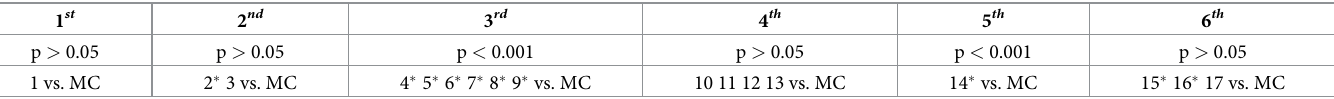
Table 3. Statistical analysis of individual step assessments. For each step identified in the first row of table (Fig 3), the second row shows the Kruskal–Wallis test result, and the third row uses an � symbol to indicate any statistically significant difference in the results of the pairwise Wilcoxon signed rank tests between the MC and the other processing chains that differ only in the use of another option in that